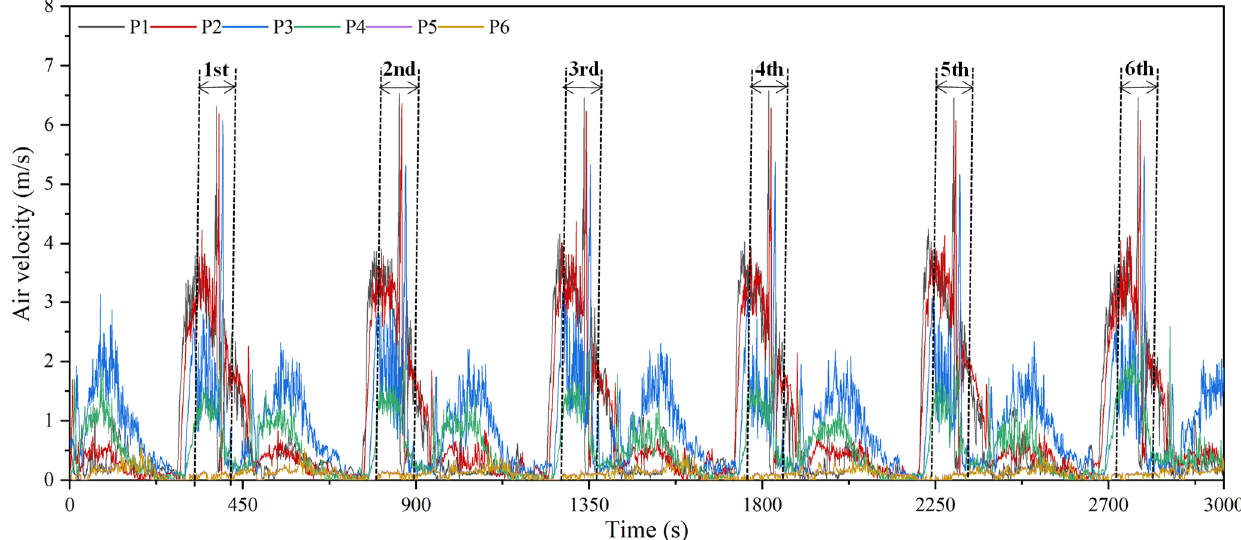
Figure 4. Variations in air velocity at the controllable vents.